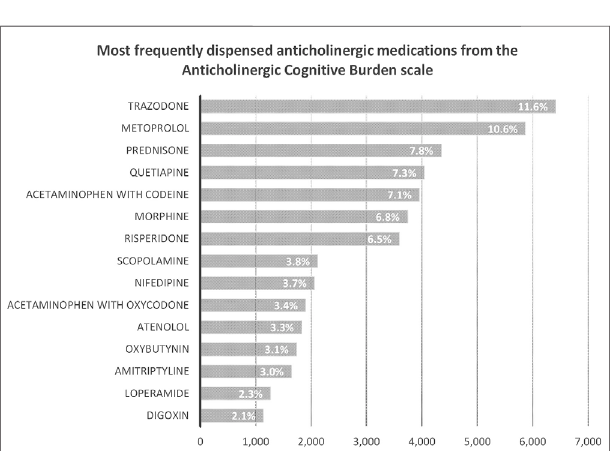
FIGURE 2 | Number and percent of Nova Scotia Senior ’ s Pharmacare Bene fi ciaries with dementia dispensed at least one medication from the Anticholinergic Cognitive Burden scale for the top fi fyeen most frequently dispensed medications.